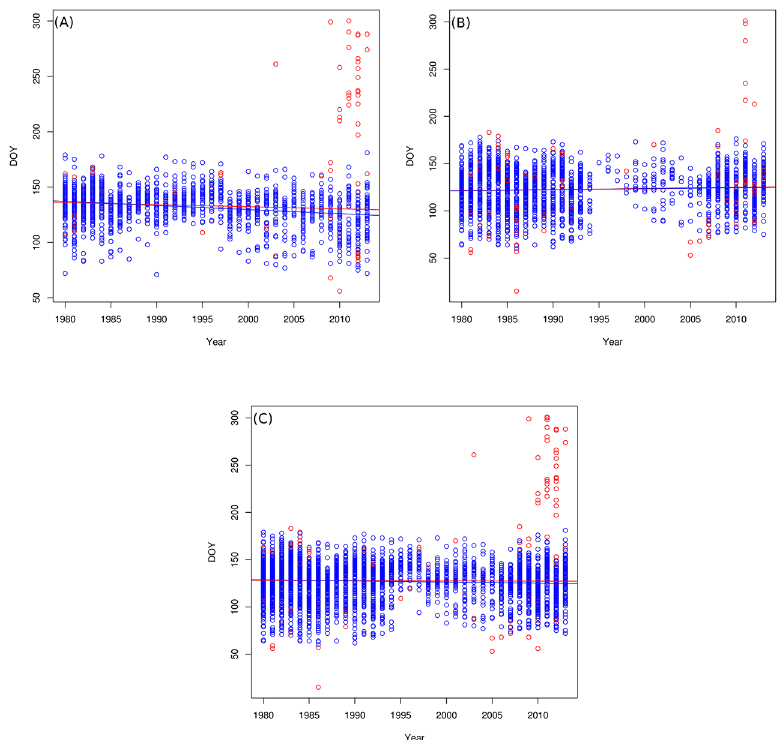
Fig 8. Comparison of the linear modeling of the original phenological observations and the consistent phenological observations. Temporal trends in the flowering onset DOY of (A) cloned lilac, (B) common lilac, and (C) pooled observations of cloned and common